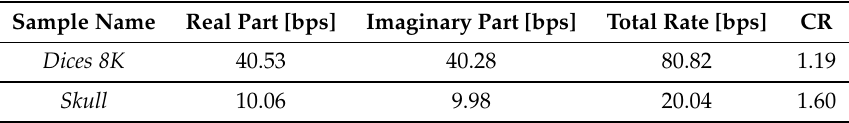
Table 3. JPEG LS compression